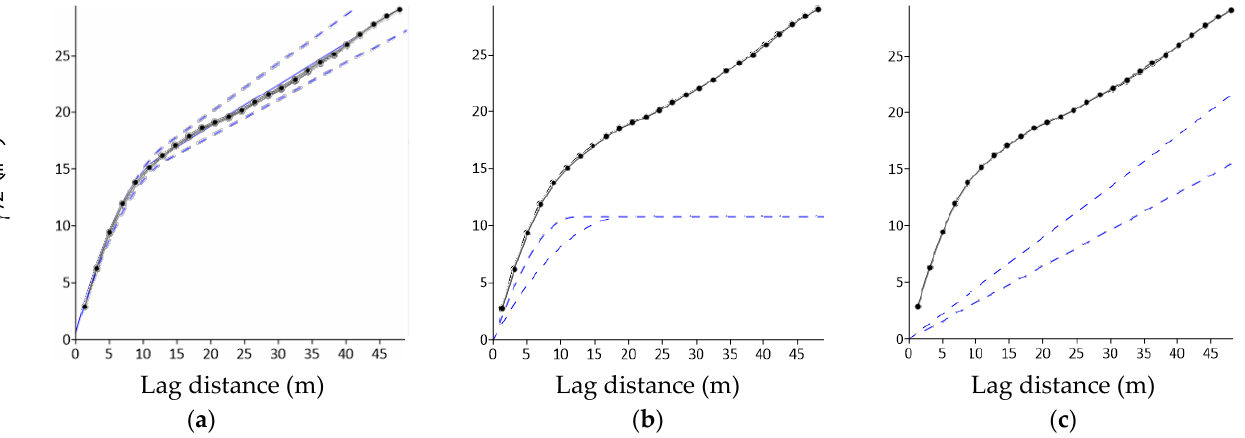
Figure 10. The empirical semivariogram of the CHM (black line with dots), with over-imposed closest theoretical semivariogram (blue continuous line); the range of variability of the theoretical semivariogram (dashed blue lines): ( a ) all the components of the semivariogram; ( b ) the quadratic model; ( c ) the linear model.